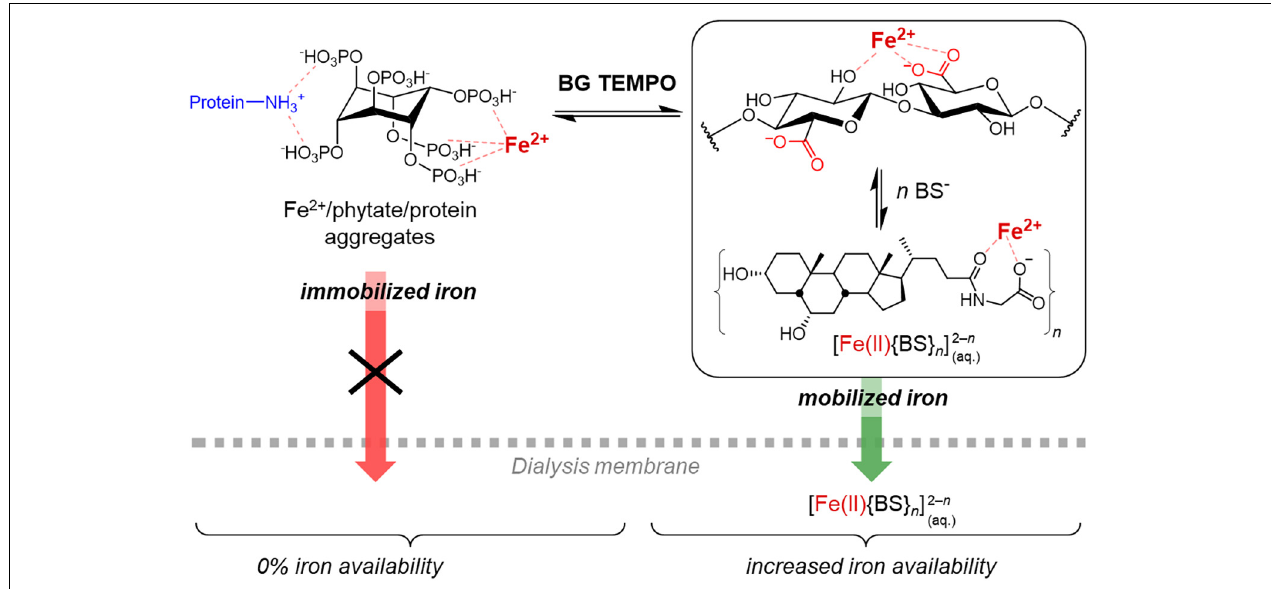
FIGURE 7 | Schematic representation of the proposed mechanism to explain the observed effect of the TEMPO-oxidised β -glucan material (BG TEMPO) with increased iron availability despite substantial phytic acid contents, by transferring Fe 2 + from large iron/phytate/protein aggregates to soluble iron/bile salt (BS) complexes that are able to cross the dialysis membrane. Glycohyodeoxycholate is shown as BS representative of the used bile